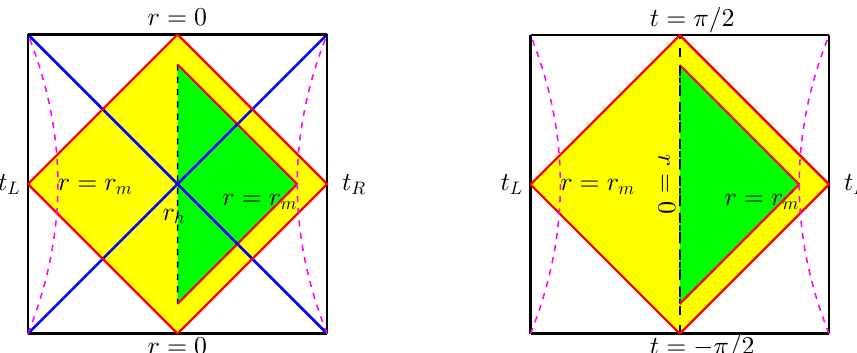
Figure 3 . Penrose diagram and the regularized WDW patch for t R = t L = 0 in the BTZ black holes when J = 0. The case for M (cid:21) 0 is shown in the left panel, where the null sheets coming from t R and t L meet each other at the surface r = 0. The case for M = (cid:0) 1 is shown in the right panel, where the null sheets coming from t R and t L will meet each other at r = 0 and t = (cid:6) (cid:25)=